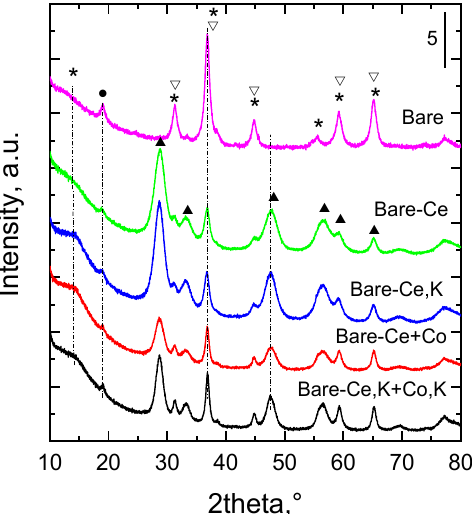
Figure 1. XRD patterns of the examined catalysts (CuK α , λ = 0.15418 nm). Designation of the reflections: *—spinel Co 3 O 4 , —CoMnAlO 4 , ● —MnO 2 , ▲ —cubic CeO 2 .